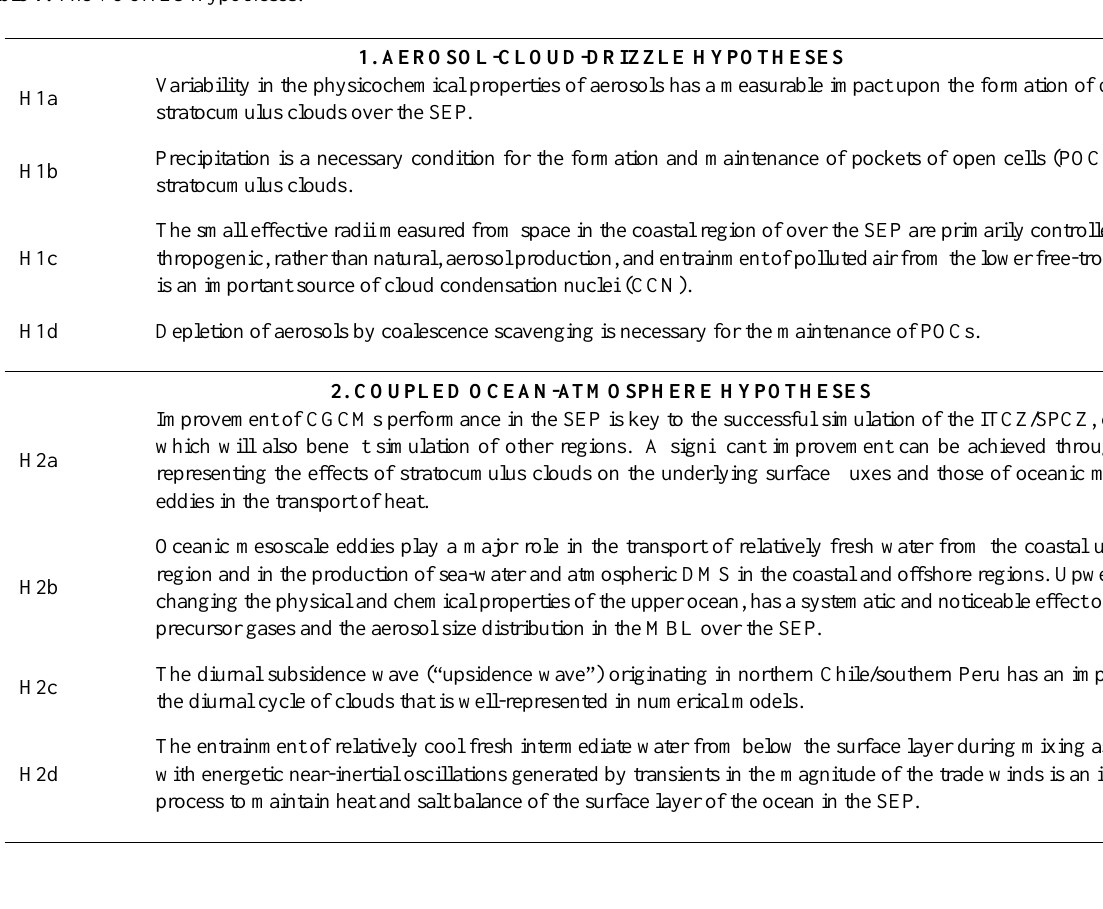
Table 1. The VOCALS